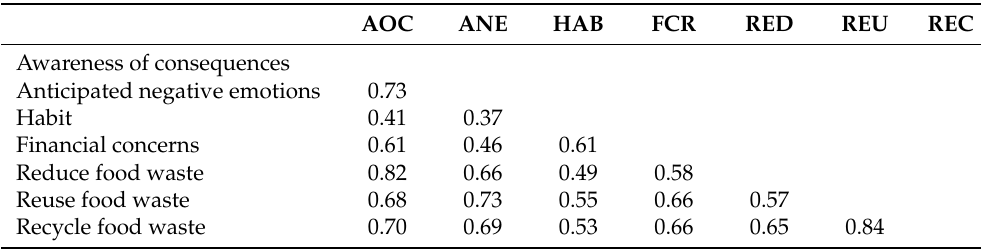
Table 3. Discriminant Validity HTMT